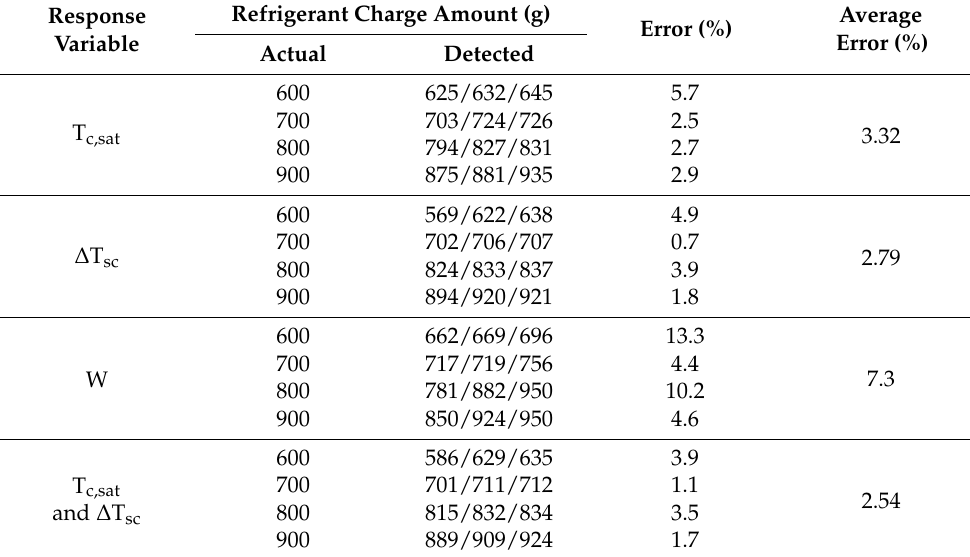
Table 5. Refrigerant charge detection